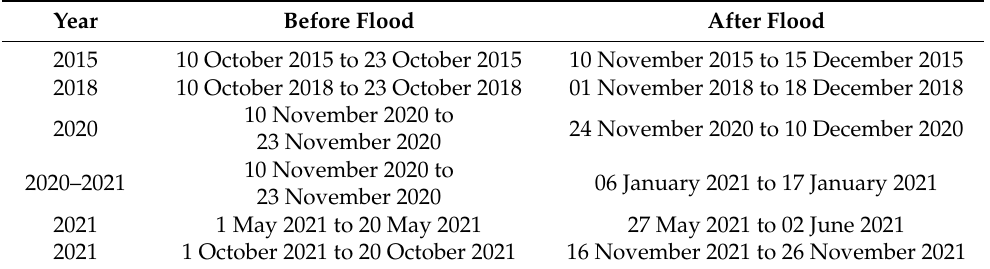
Table 1. Window periods for Sentinel-1 median images extraction before and after the major floods. Year Before Flood After